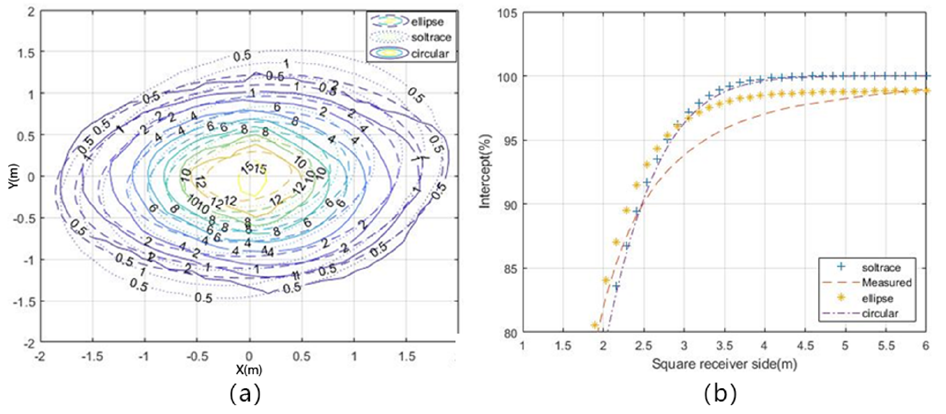
Figure 12. ( a ) Contours of the measured and computed flux distribution (kW/m 2 ): Heliostat #6, ( b ) measured and computed intercepts vs. the side length of a square receiver: Heliostat #6